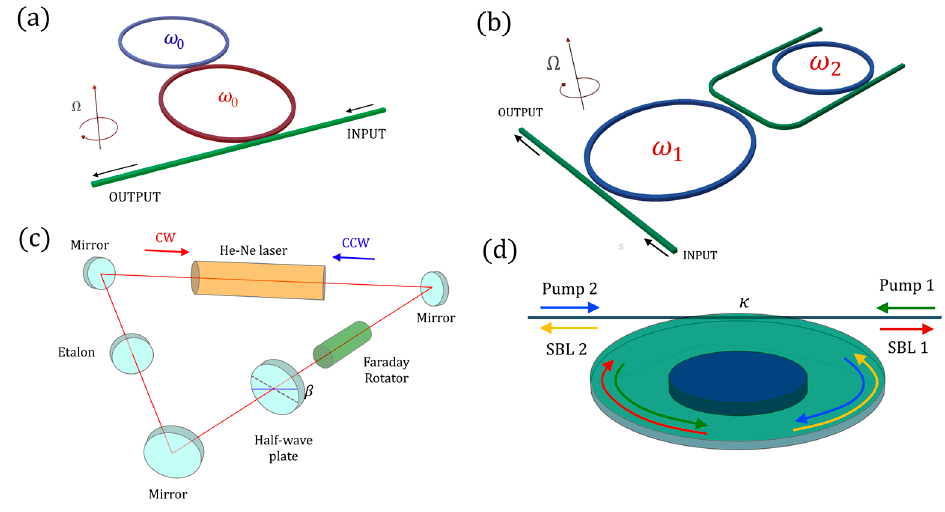
Figure 14. ( a ) Schematic of a parity-time-symmetric laser gyroscope system (proposed in [78]). ( b ) Schematic of an anti-parity-time-symmetric gyroscope (proposed in [81]). ( c ) Non-Hermitian ring laser gyroscope (proposed in [73]). ( d ) Brillouin laser gyroscope at the EP (proposed in [83]).